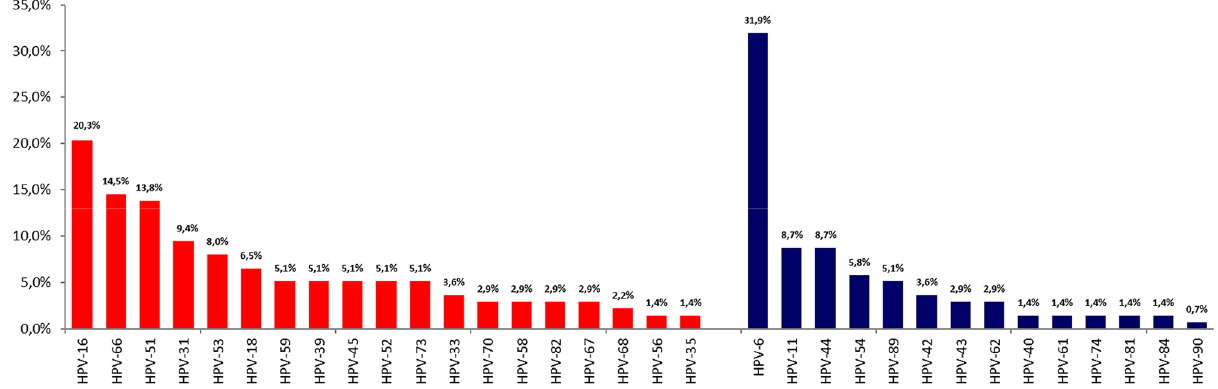
Figure 1. Type-specific distribution of hrHPV (red) and lrHPV (blue) among 138 men HPV + with presence of clinical lesions (Group